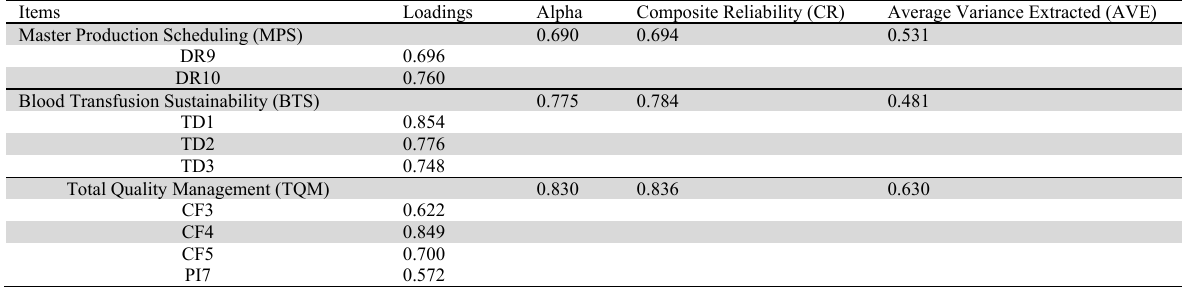
Loadings, Cronbach alpha, reliability and convergent validity-TQM mediation measurement model